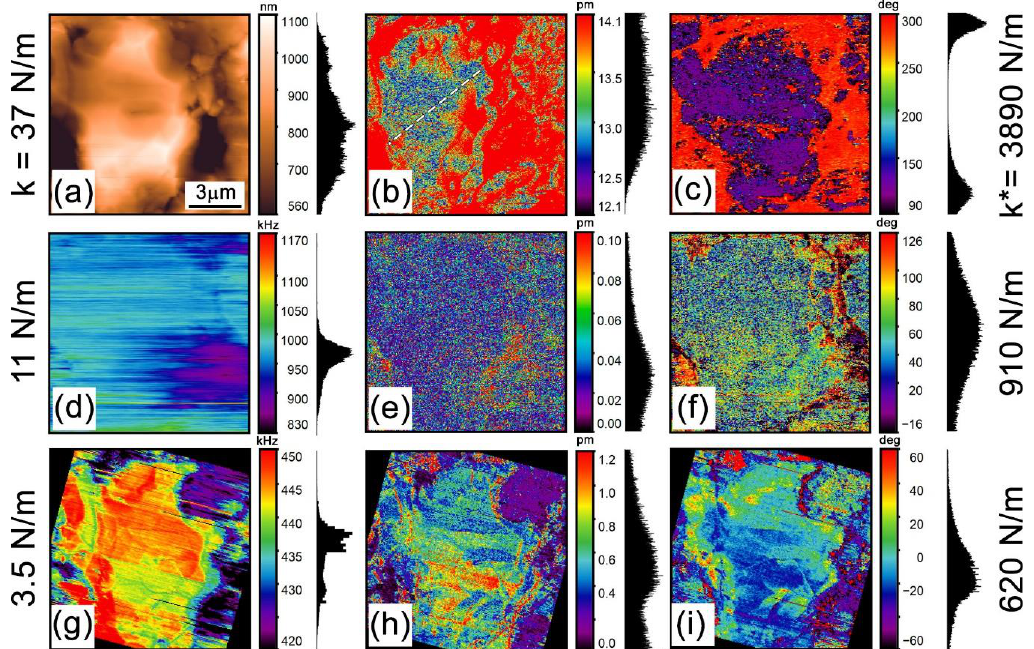
Figure 2. ESM in the active ionic particle shown in Figure 1. Three cantilever probes with different stiffness (denoted on the left side of the figure) were used to obtain the images. The corresponding contact stiffness is shown on the right side of the figure. Images in one row were obtained simultaneously with one probe. ( a ) Topography, ( b ) amplitude, and ( c ) phase measured with the 37 N/m cantilever ( V ac = 10 V) in the 3.5 kHz LF ESM. ( d ) Dual AC resonance tracking (DART) resonance frequency, ( e ) amplitude, and ( f ) phase measured with the 11 N/m cantilever ( V ac = 20 V). ( g ) DART resonance frequency, ( h ) amplitude, and ( i ) phase measured with the 3.5 N/m cantilever ( V ac = 10 V). The signal histograms are displayed on the right from the color scalebars of the corresponding images. The dashed line in ( b ) indicates the line used to extract the profile of the ESM amplitude displayed in Figure 5a.